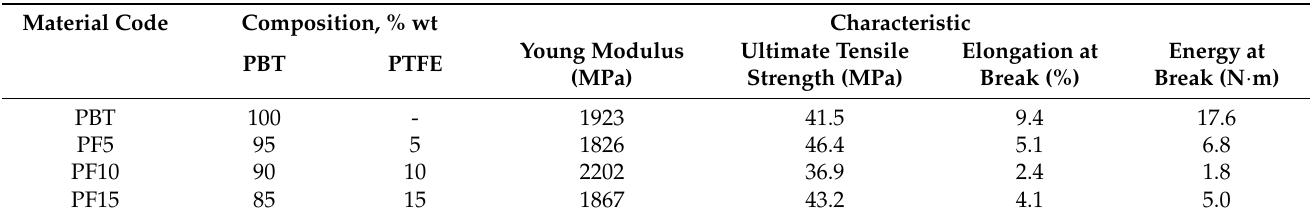
Table 1. Average values for mechanical characteristics of the polymeric blends tested [23].